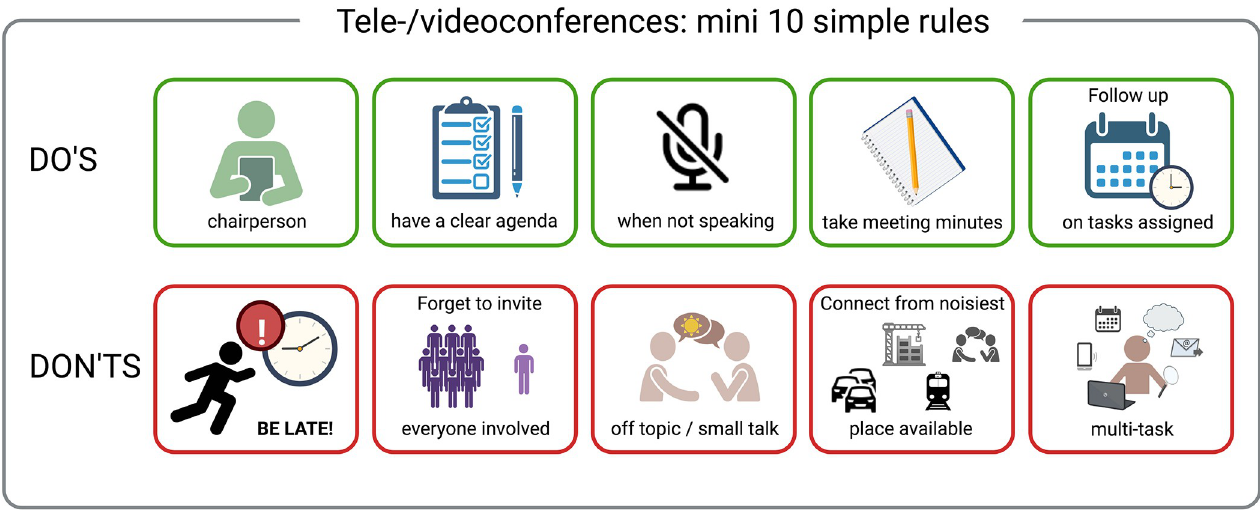
Fig 2. Mini 10 simple rules for tele-/videoconferences. If we could stick to these 10 simple rules during a tele-/videoconference, this type of meeting could be more efficient and less of a strain. This figure was partly created with BioRender.com except for the icons of the muted microphone, construction work, traffic, running late person, public transport, and e-mail. The icon of the muted microphone and traffic were downloaded from https://icons8.com/ and used in unmodified form.